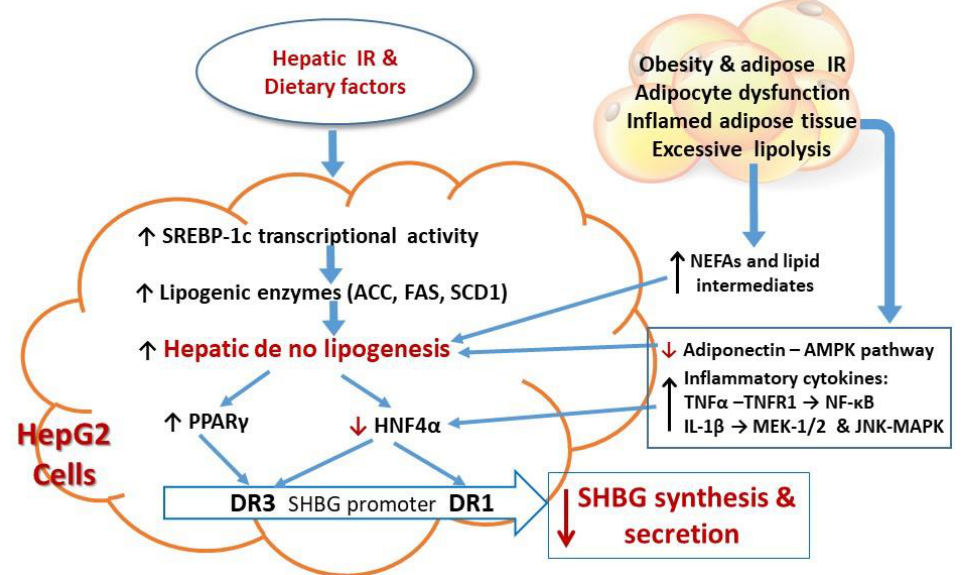
Figure 2. The molecular mechanism by which insulin resistance mediates various factors/pathways that reduce SHBG production, in part by down-regulating HNF-4α in the liver. 1) Hepatic insulin resistance with dietary factors (fructose and sucrose) increases monosaccharide delivery to the liver to cause reduction of hepatic HNF-4α levels and SHBG production through stimulating sterol regulatory element binding protein 1c (SREBP-1c), which promotes hepatic de no lipogenesis (DNL) by enhancing the transcription of several lipogenic enzymes, notably adenosine triphosphate citrate lyase